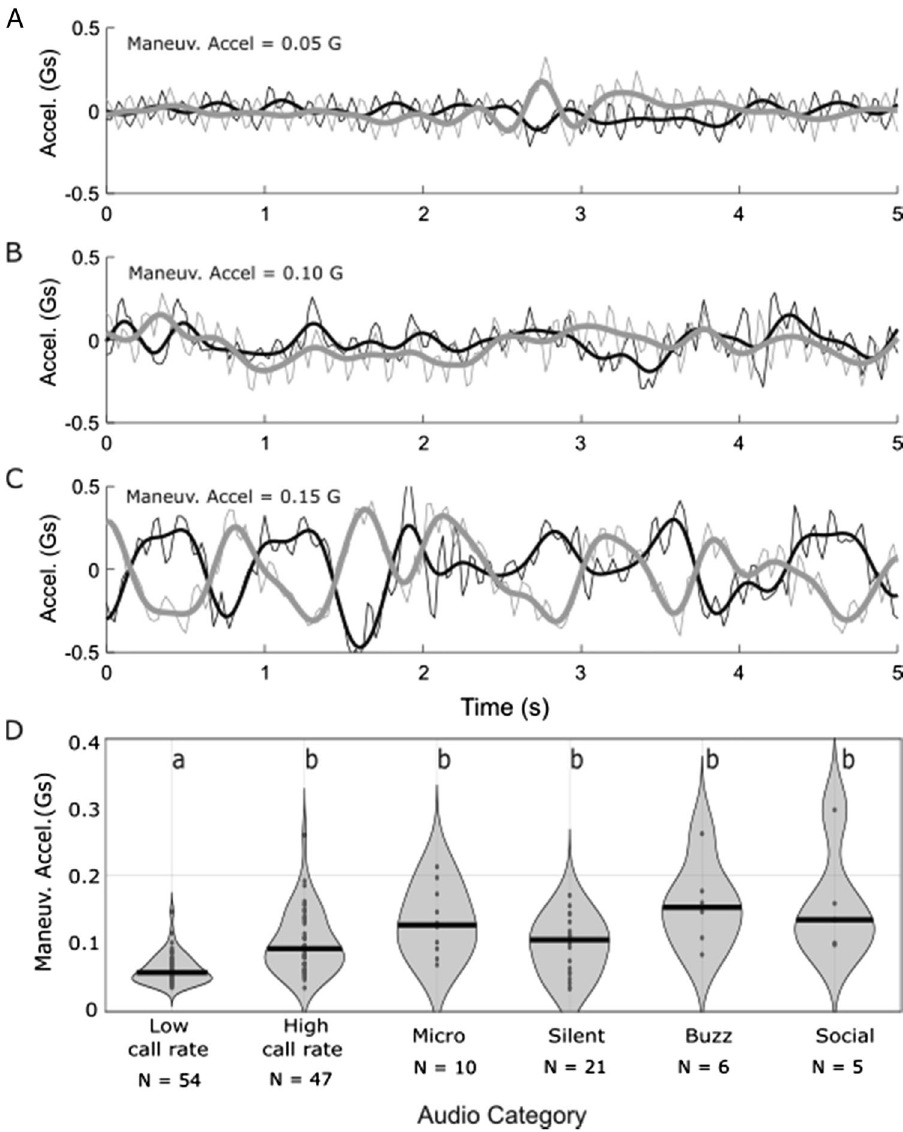
Figure 3. Flight maneuvering accelerations. Example acceleration traces show ( A ) low, ( B ) medium and ( C ) high degrees of maneuvering. Raw acceleration values are shown for lateral (thin black lines) and anterior– posterior (thin gray lines) axes. The dorsoventral axis was not used because it was dominated by wingbeat accelerations. Thick black and grey lines show accelerations with a 4 Hz low-pass filter that removes wingbeat frequency cycles. The root mean square of low pass filtered accelerations was taken as the “maneuvering acceleration” for each recording and traces with low, medium, and high values were chosen for illustration. ( D ) Violin plots show the probability density functions of maneuvering accelerations during different acoustic events. Thick black lines indicate median values and small black dots show individual values for each 10 s recording. Letters above call types indicate groupings with significantly different medians (see text for statistics). Note that sample sizes for acoustic events are lower here because not all acoustic recordings had accompanying accelerometer data (See